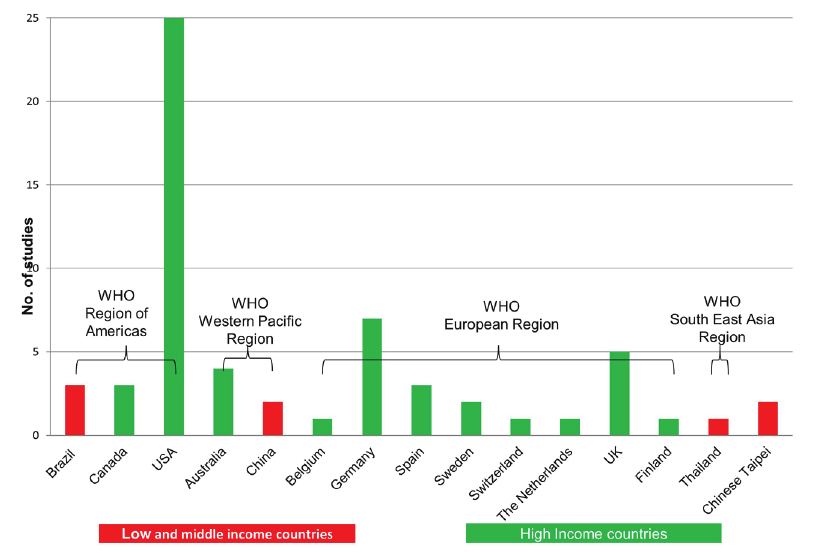
Figure 2. Country of origin of included, examined studies for low– and middle–in- come and high income countries